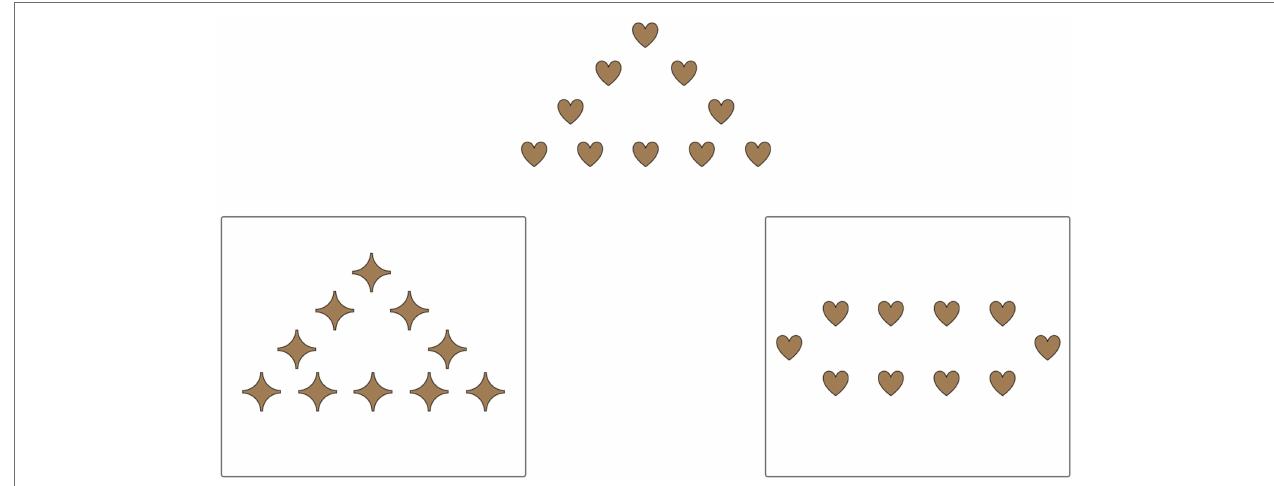
FIGURE 5 | Example trial from visual processing task.